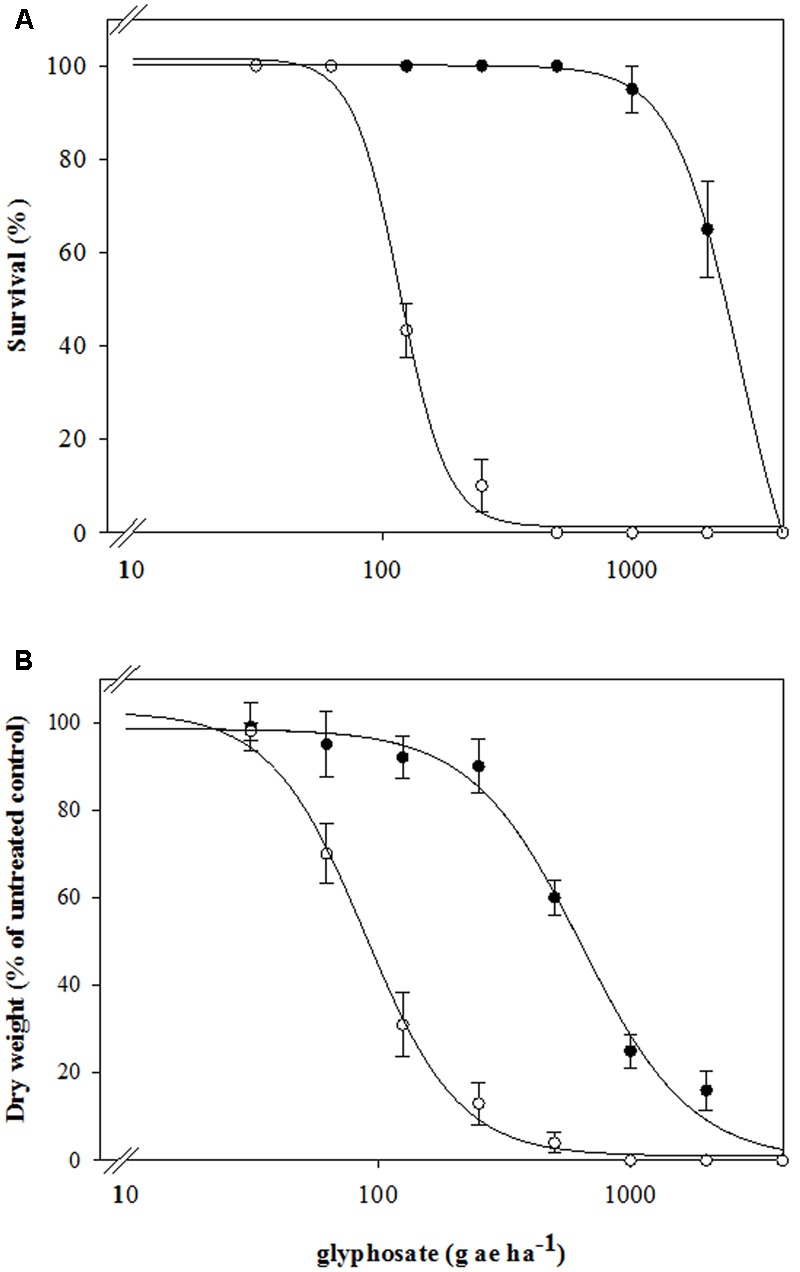
Glyphosate dose-response on (A) survival and (B) above-ground dry weight expressed as percentage of the mean untreated control of the R (•) and S (∘) biotypes of rigid ryegrass. Symbols denoted mean (n = 5) ± standard errors of the mean.